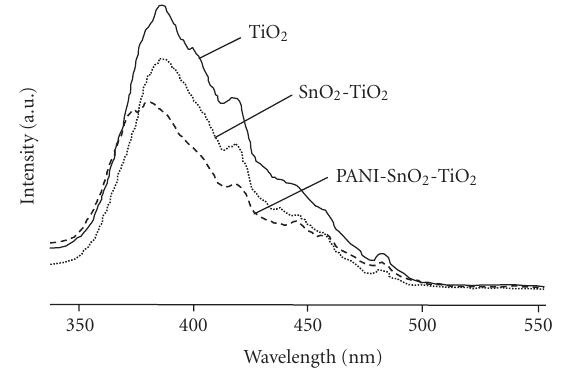
Figure 7: Photoluminescence (PL) spectra of photocatalysts.